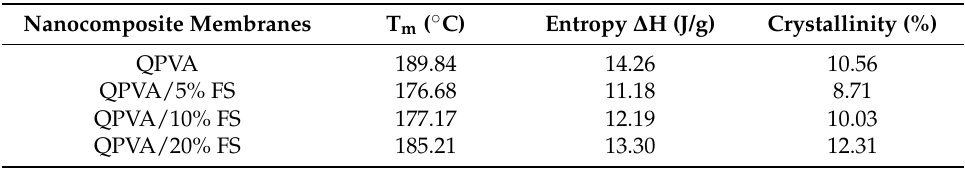
Table 1. Entropy and crystallinity values of pristine QPVA and QPVA nanocomposite membranes with different percentages of fumed